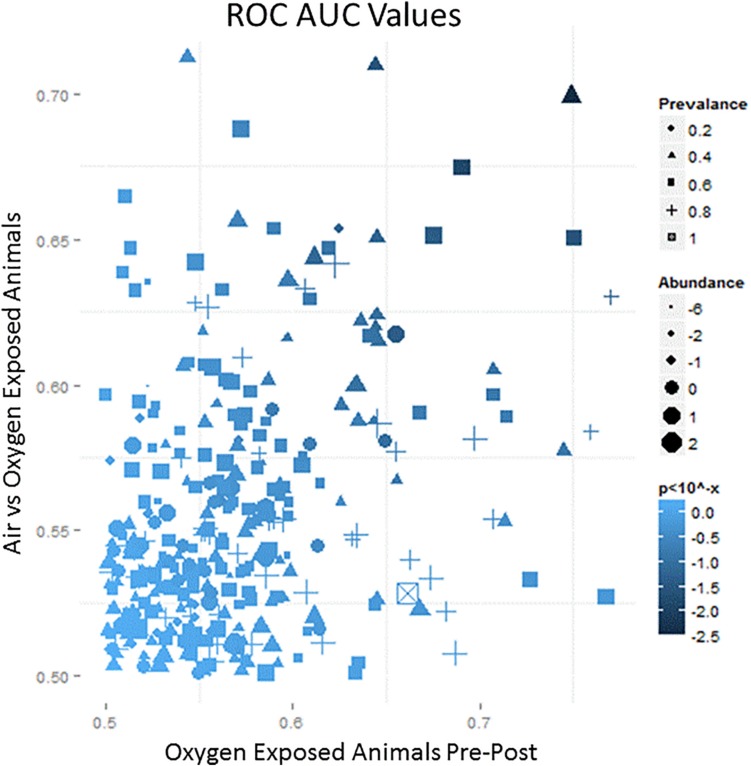
A representative schematic of the VOC content collected from breath samples over the course of the exposure. The x-axis represents the ROC/AUC score (probability) that a VOC collected from an oxygen-exposed swine will change from baseline during the exposure period. The y-axis represents the ROC/AUC score that a VOC collected from the oxygen-exposed swine during the exposure period will be present in the breath samples collected from air-exposed swine during the exposure period. Symbol shape, area, and shading represent relative prevalence, abundance, and significance, respectively.